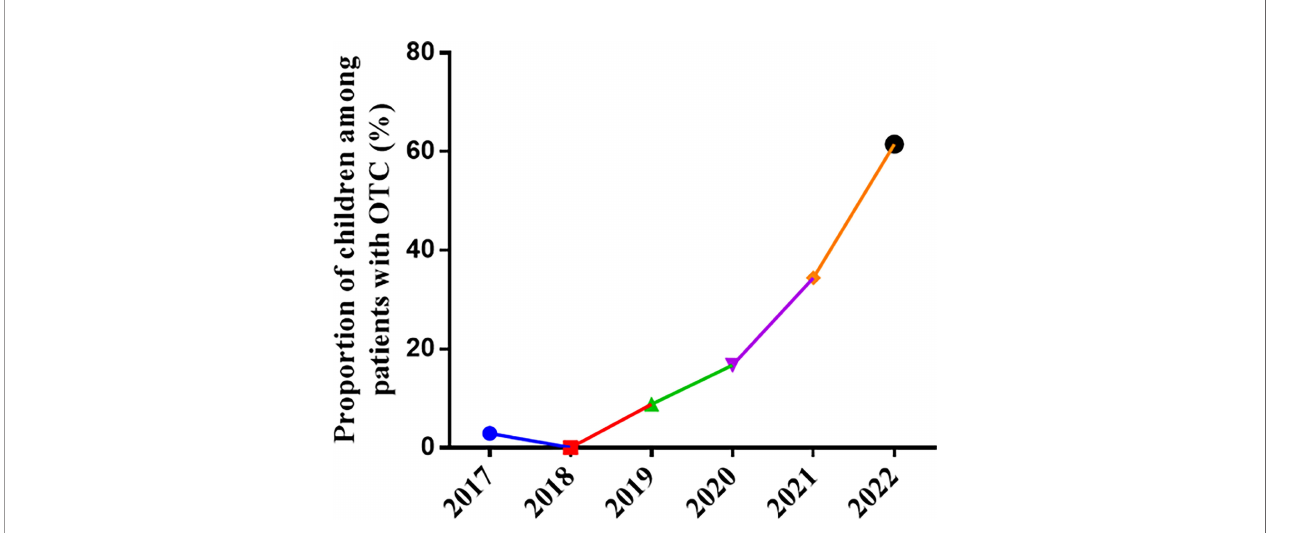
FIGURE 3 | The proportion of children among patients with OTC per year. OTC, ovarian tissue